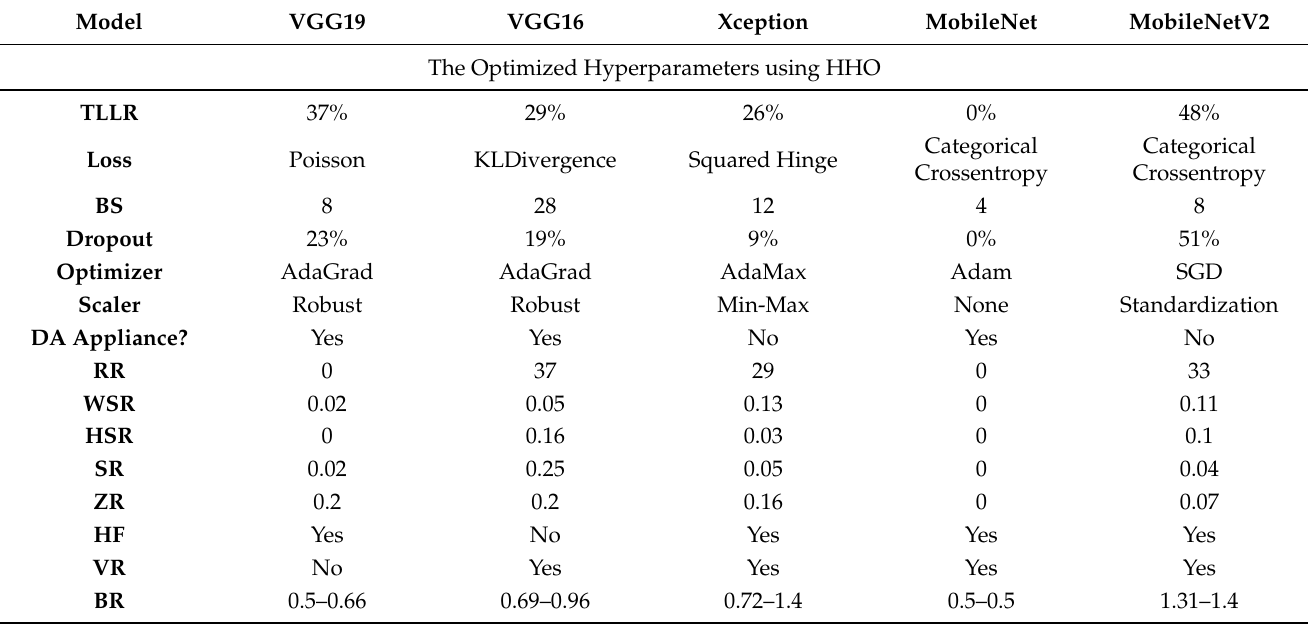
Table 7. The reported results concerning the “Monkeypox Images Dataset (MPID)” after fine-tuning and hyperparameter optimization using